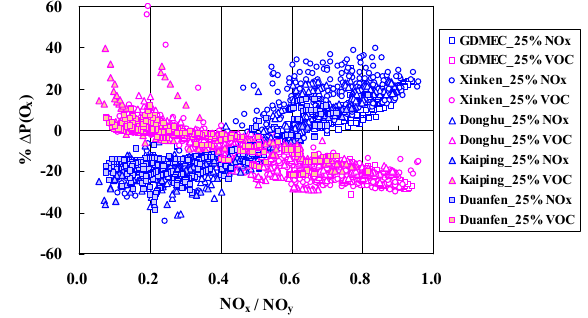
Fig. 16. The percentage change in P (O x ) due to a 25% reduc- tion in anthropogenic emissions of NO x (25%NO x ) and VOCs (25%VOC) as a function of the NO x /NO y ratio at the GDEMC, Xinken, Donghu, Kaiping, and Duanfen sites from layers 1 to 7 for the period of 09:00–17:00LST during 16–22 October